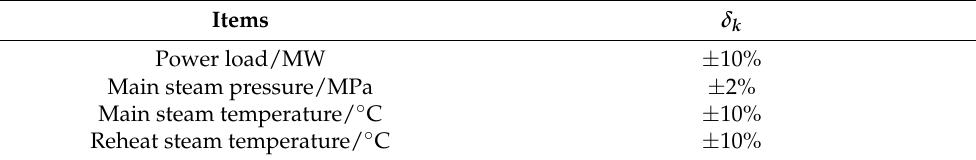
Table 1. The thresholds of steady-state detection parameters [23]. Items δ k